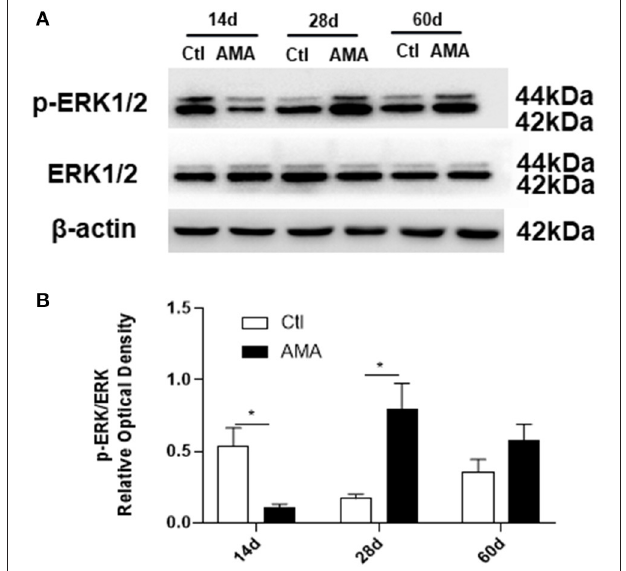
FIGURE 5 | Effects of AMA on ERK1/2 phosphorylation in the hippocampi of AMA offspring. (A) Representative images showing the expression of ERK1/2 and p-ERK1/2 in hippocampal tissue samples collected from Ctl and AMA rats at three different time points (P14, P28, and P60). (B) Quantitative analyses of ERK phosphorylation at different times for each group. Data are shown as the mean ± SEM, * p < 0.05 compared with Ctl, n = 6 per group.